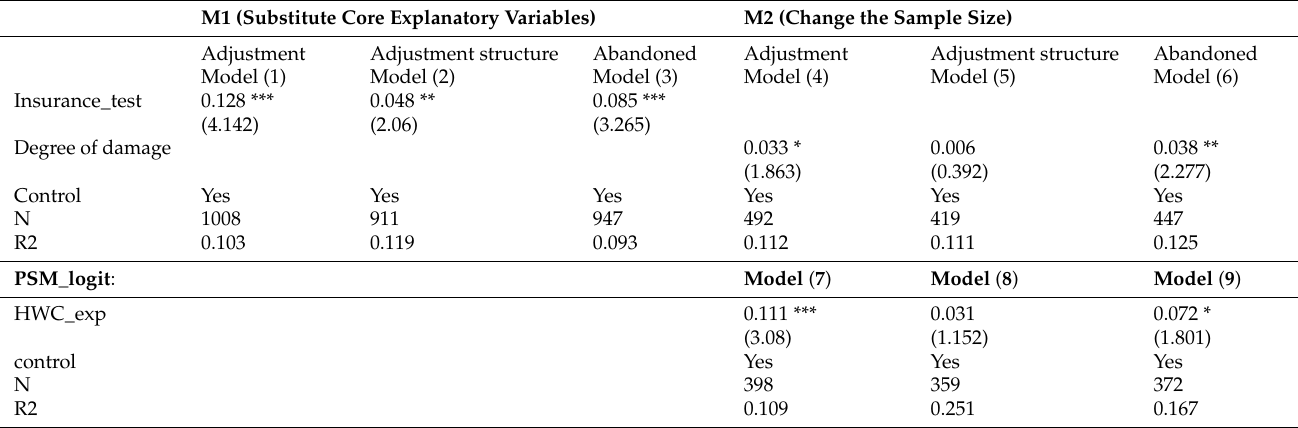
Table 7. Robustness